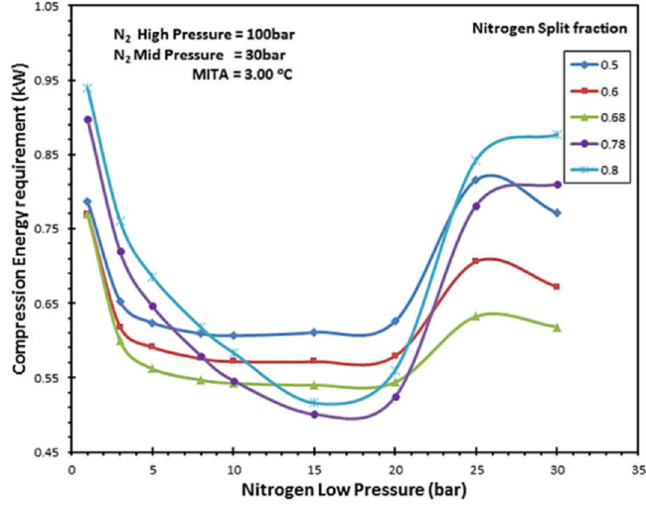
Figure 16. Low-pressure optimization in the dual nitrogen expander process [57]. Reproduced with permission from Elsevier (license number 5413360697553).